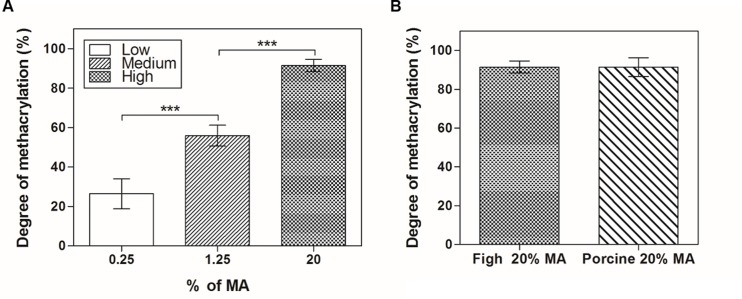
Degree of methacrylation as determined by TNBS assay.(A) Various volume percentages of methacrylic anhydride (0.25%, 1.25% and 20%) were analyzed to investigate the degree of methacrylation of the synthesized fish GelMA. (B) Comparison of a high degree of methacrylation (20% MA) according to the origin of gelatin (fish GelMA vs. porcine GelMA); there was no significant difference. The percentage of incorporated substitution was calculated by comparing the amount of remaining amino groups (-NH2) in GelMA to that in pristine gelatin. Error bars represent standard deviations (SDs) of measurements performed on six samples.